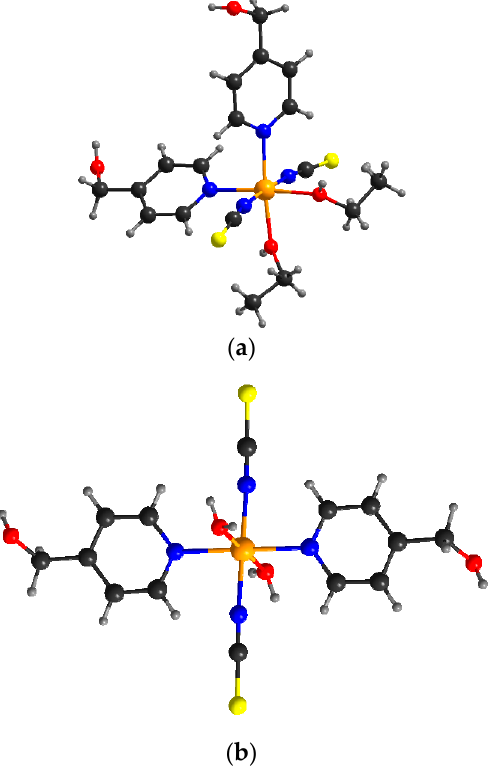
Figure 2. View of the discrete complexes in the crystal structure of 2 ( a ) and 3 ( b ), showing the coordination sphere of the Co(II) cations. ORTEP plots of 2 and 3 can be found in Figures S4 and S5 in the Supplementary Material.